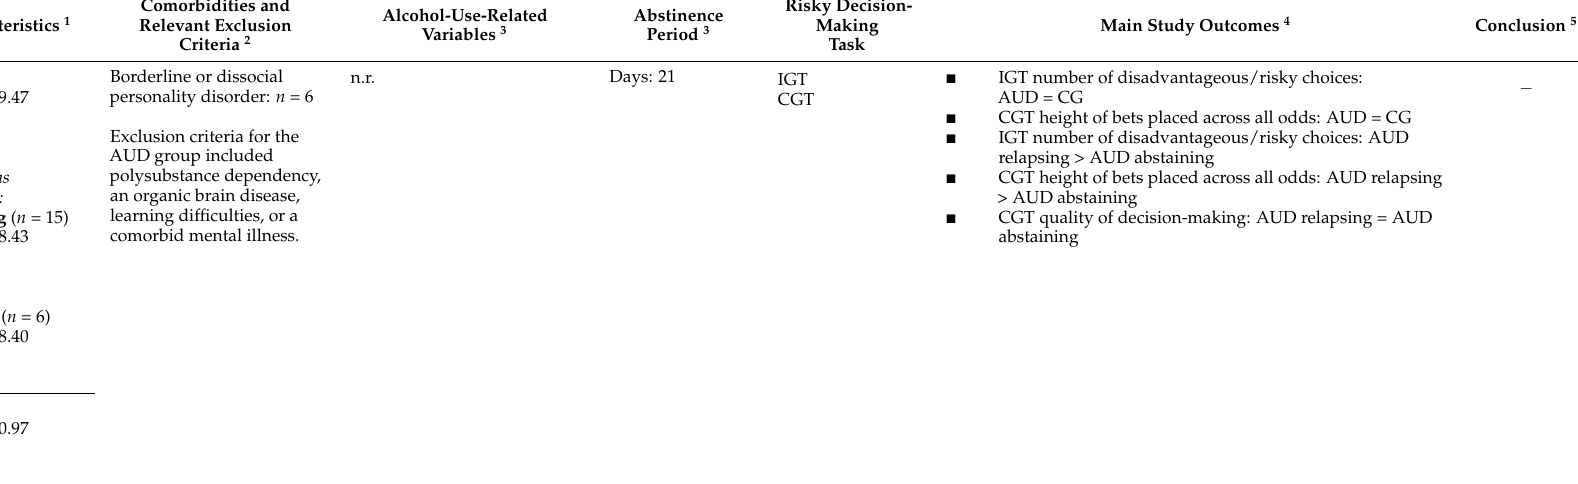
CGT quality of decision-making: AUD relapsing = AUD abstaining